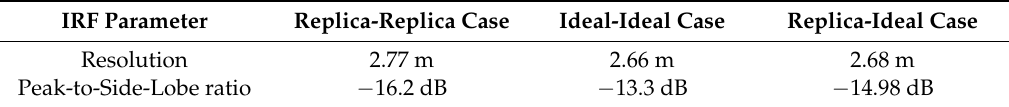
Figure 4. ( a ) Comparison between the ideal chirp and the chirp extracted from internal calibration; ( b ) Range-compressed Impulse Response Function (IRF) comparison. Table 4. Range IRF analysis results .